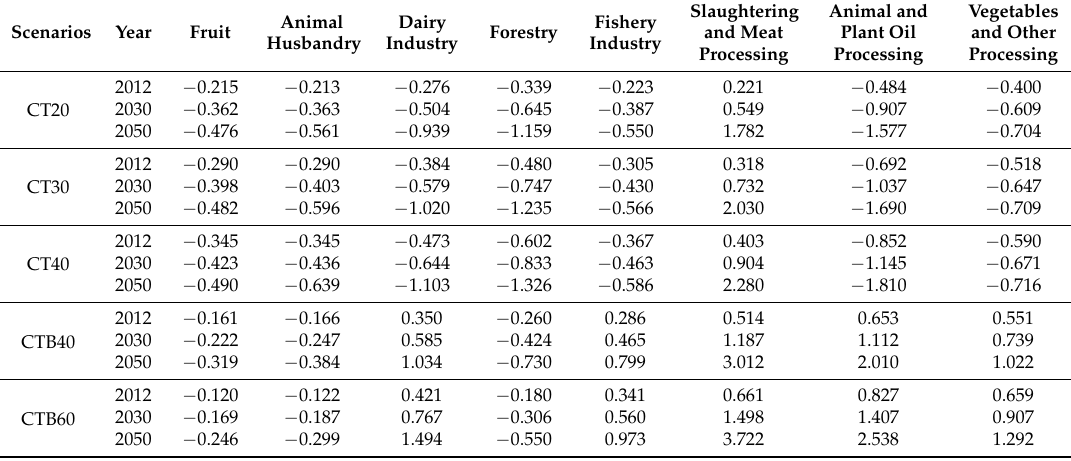
Table 12. The changes in the households’ income in agriculture-related sectors under different scenarios compared with the BAU scenario (%) (from fruit to vegetables and other processing).